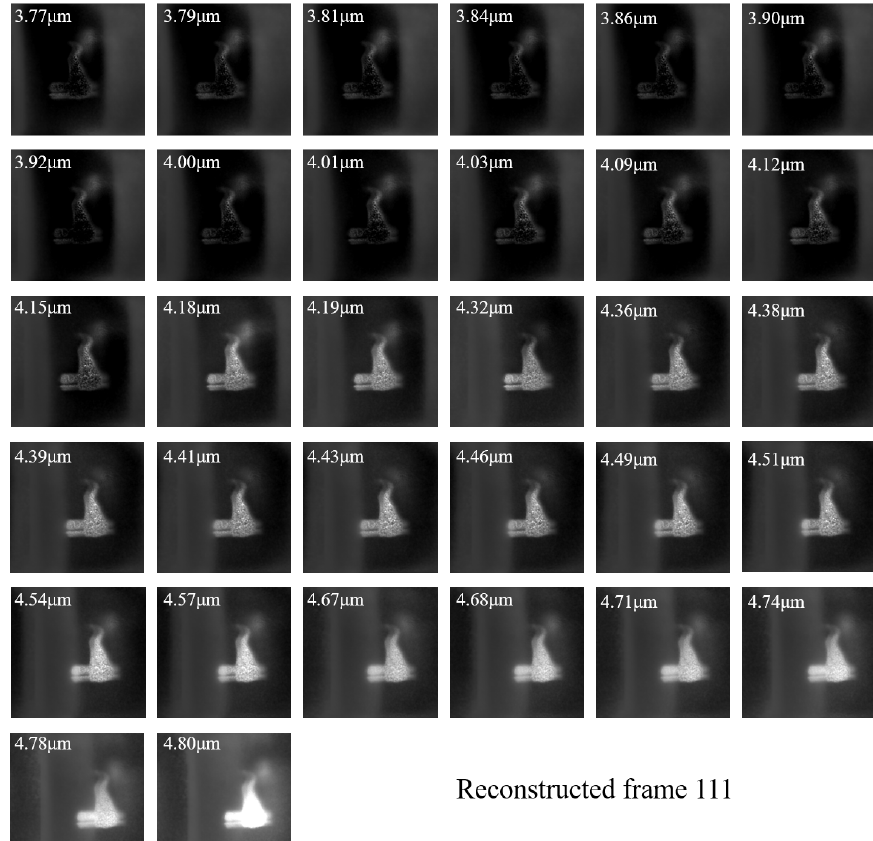
Figure 18. Reconstructed spectral images by our reconstruction